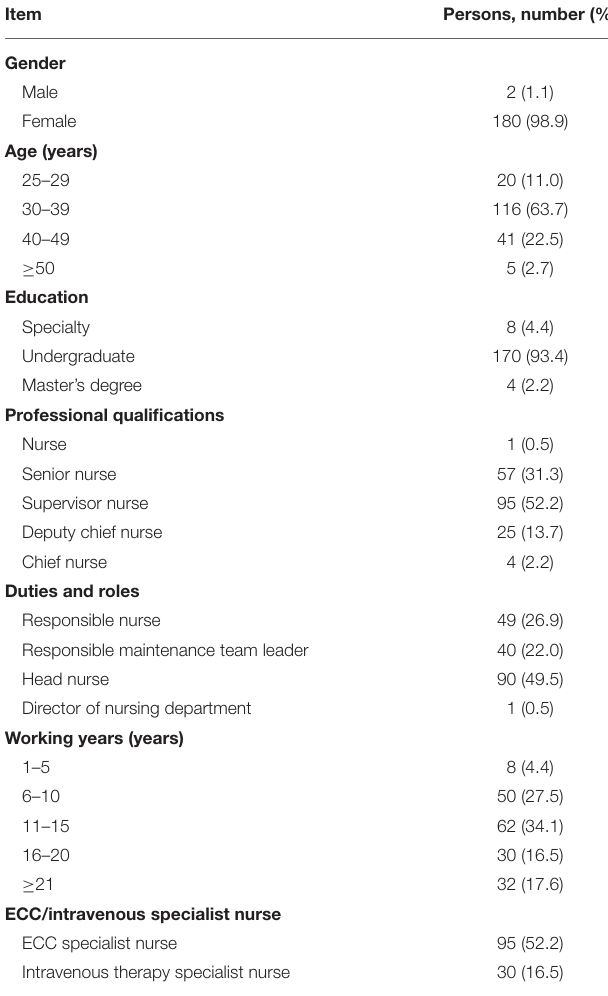
TABLE 1 | General information of respondents ( n =